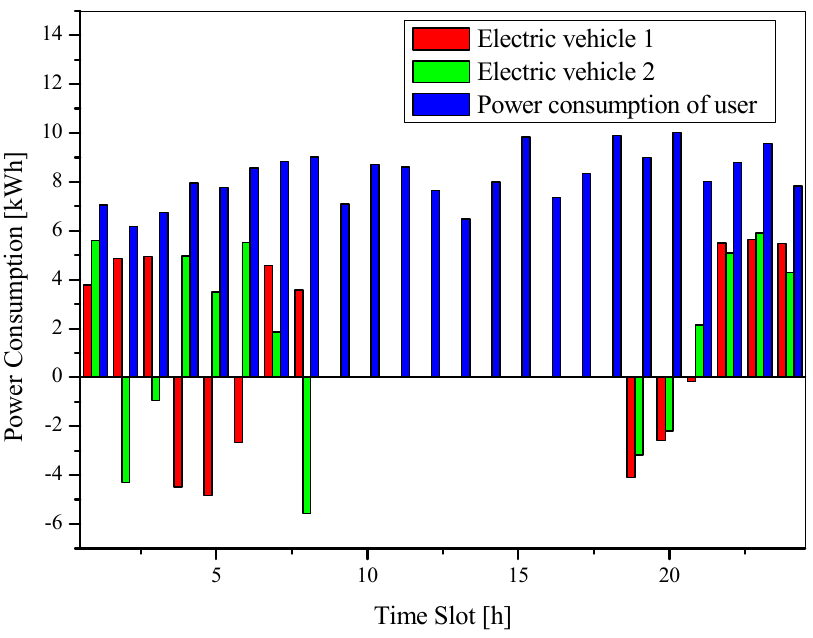
Figure 3. Power consumption of user at each time slot.